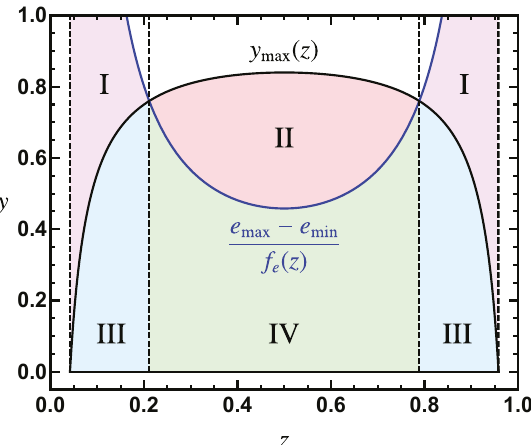
Figure 21 . Phase space diagram in ( z; y ) coordinates (black lines) showing the curve for which the C-parameter soft measurement function equals the maximum allowed value C max = 0 : 75. Di(cid:11)erent colors correspond to the di(cid:11)erent integration regions of the soft non-singular distribution. To make this plot we use the numerical value ^ m = 0 :